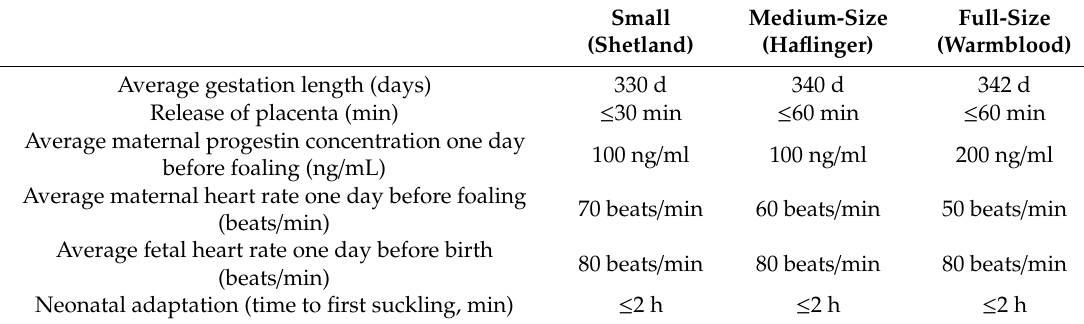
Table 3. Suggested mean values for clinical parameters used for assessment of the late pregnant mare, her fetus and newborn foal in horse breeds of di ff erent size (note that values are approximate estimates based on a limited number of